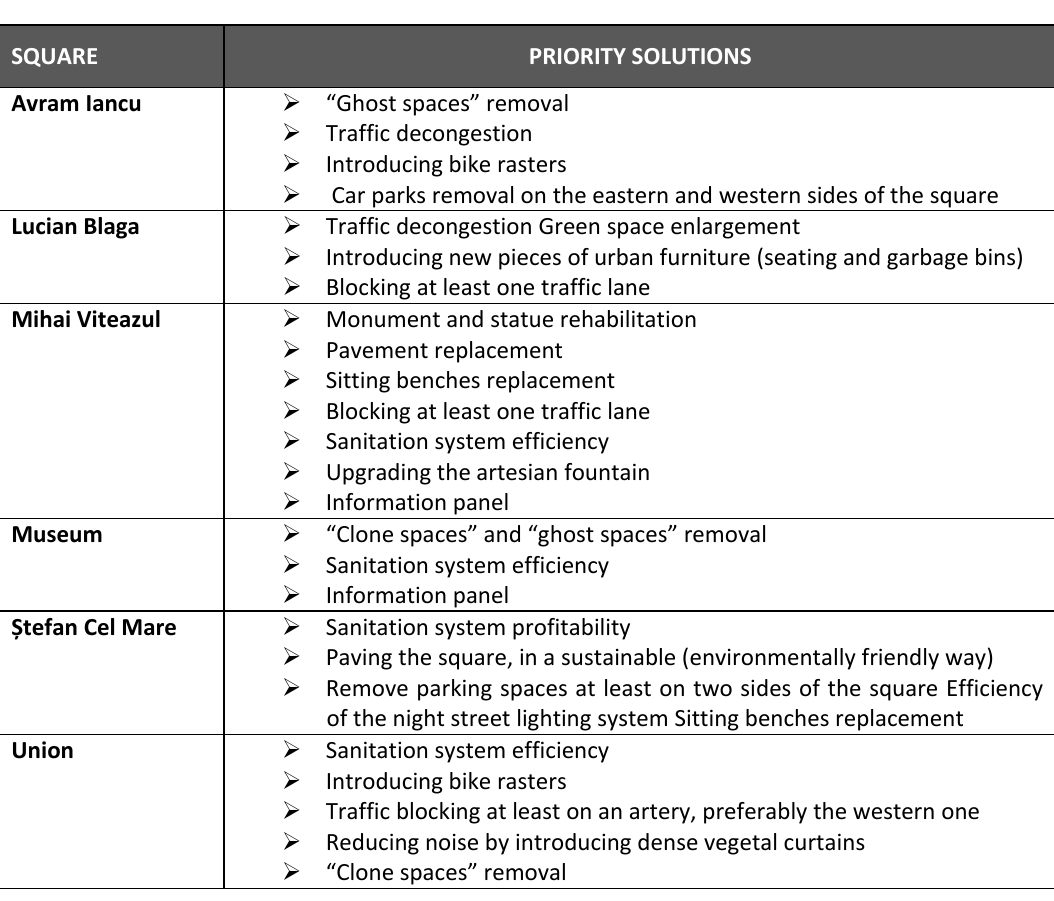
Table 3: Goals to reduce existing